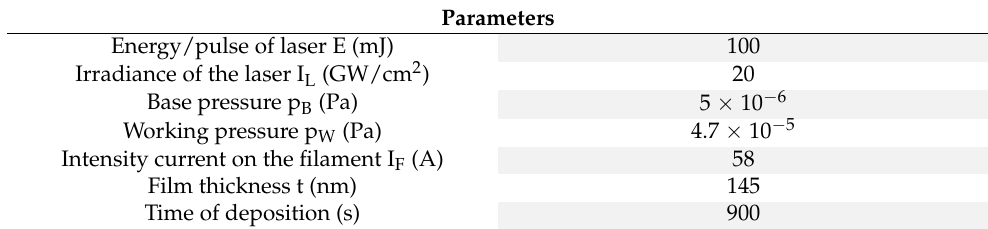
Table 1. List of the experimental parameters for depositing CoNiAl thin films. Parameters